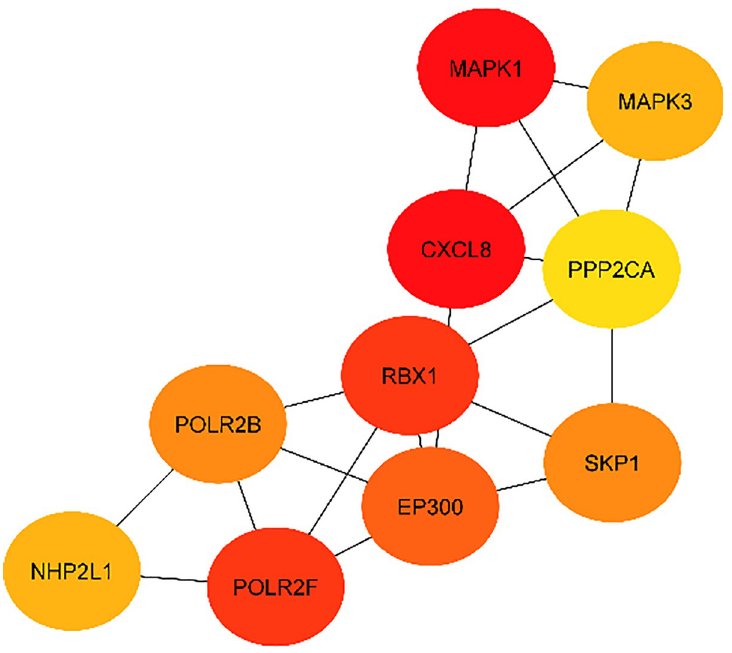
Fig 8. Top 10 nodes based on their degree.